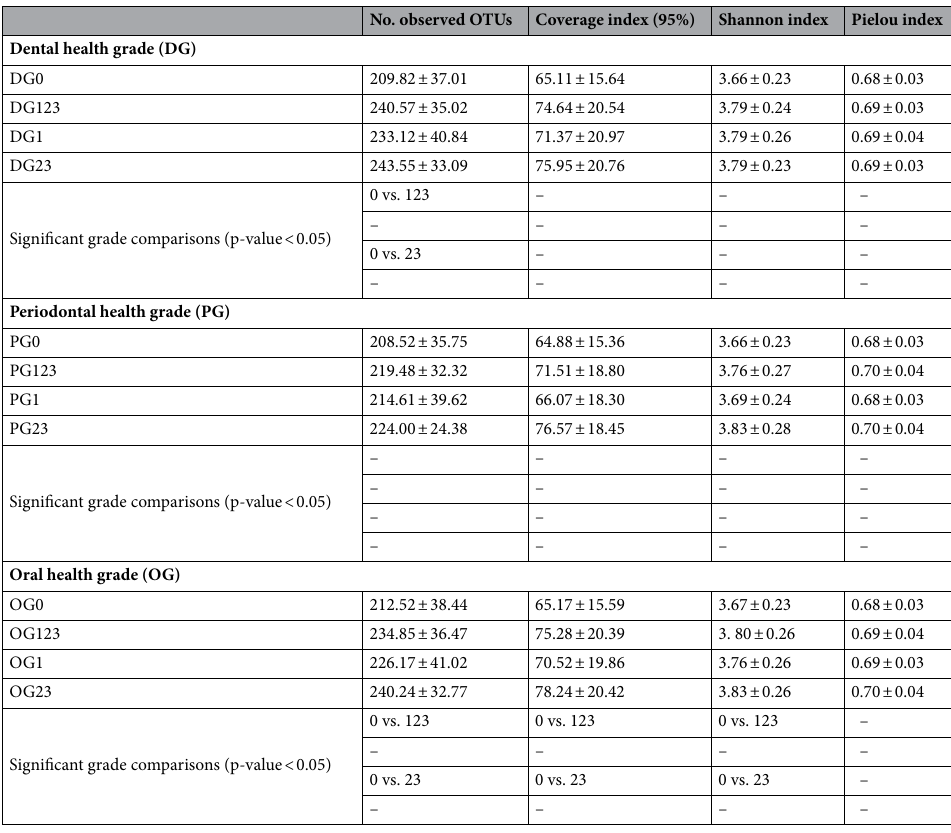
Table 2. Alpha diversity indicators in the different grades of the dental and periodontal subscales, as well as in the scale of overall oral health. The following four comparisons were performed in both the dental and periodontal subscales as well as the scale of overall oral health: grade 0 vs. grade 123; grade 0 vs. grade 1; grade 0 vs. grade 23; grade 1 vs. grade